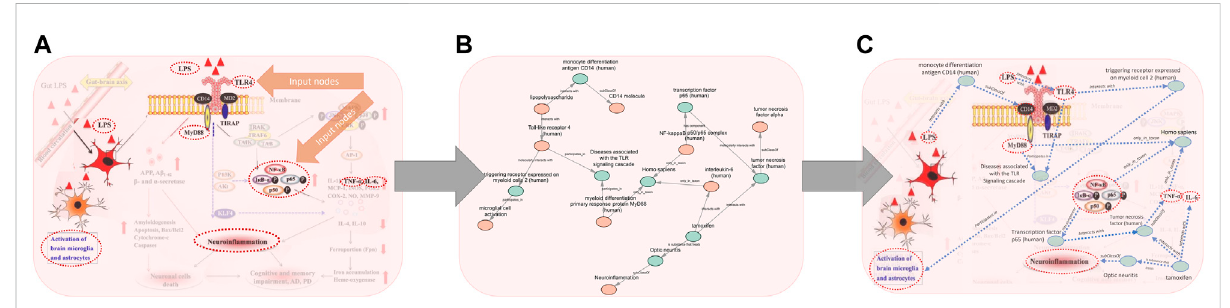
FIGURE 3 Visualization of the process of generating a subgraph for the Figure 1C example. (A) Selection of concepts from the original cartoon to index according to the chosen KG, (B) resulting subgraph after semantic actions and path search through the graph to recapitulatethe edges betweenthe original nodes, (C) the same information from (B) though shown with the same artistic portrayal as the original cartoon, with intermediate nodes